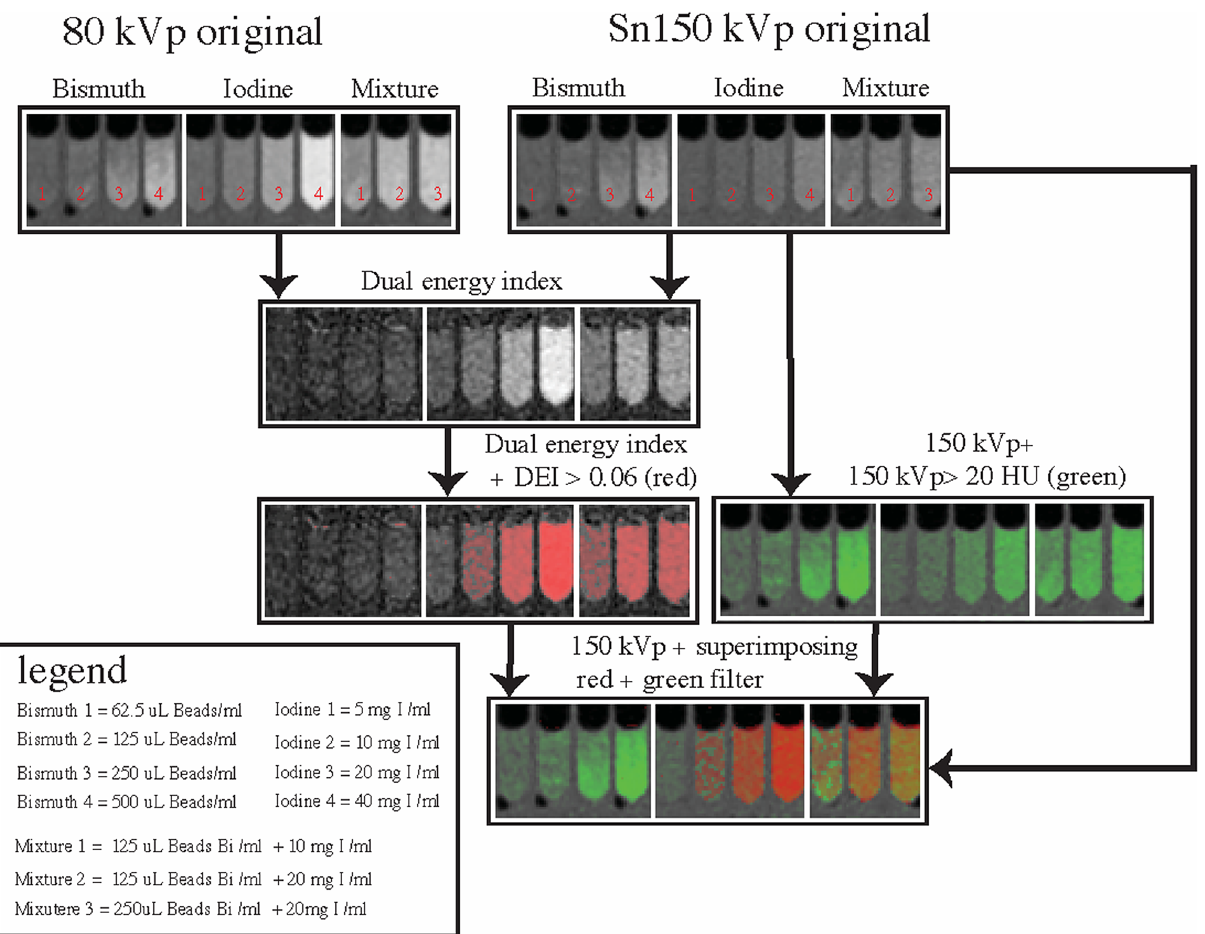
Figure 8. Dual energy CT post-processing workflow and outcome for bismuth, iodine and mixture agarose phantoms. Row 1: Original 80 kVp and Sn150 kVp energy reconstructions. Row 2: A dual energy index (DEI) image is calculated from the two scans. Row 3: DEI values greater than 0.06 are superimposed on the original DEI image as a red color map. (left image). Image intensity values above 20 HU in the Sn150 kVp image are superimposed on the original image as a green color map (right image). Row 4: Combined DEI and HU color maps as blended color maps superimposed on the Sn150 kVp image. High HU above the threshold (green) occurs for both iodine and bismuth, however, the increase in DEI (red) only occurs for iodine. Therefore, bismuth alone can be differentiated from either iodine alone or a bismuth/iodine mixture, due to the absence of